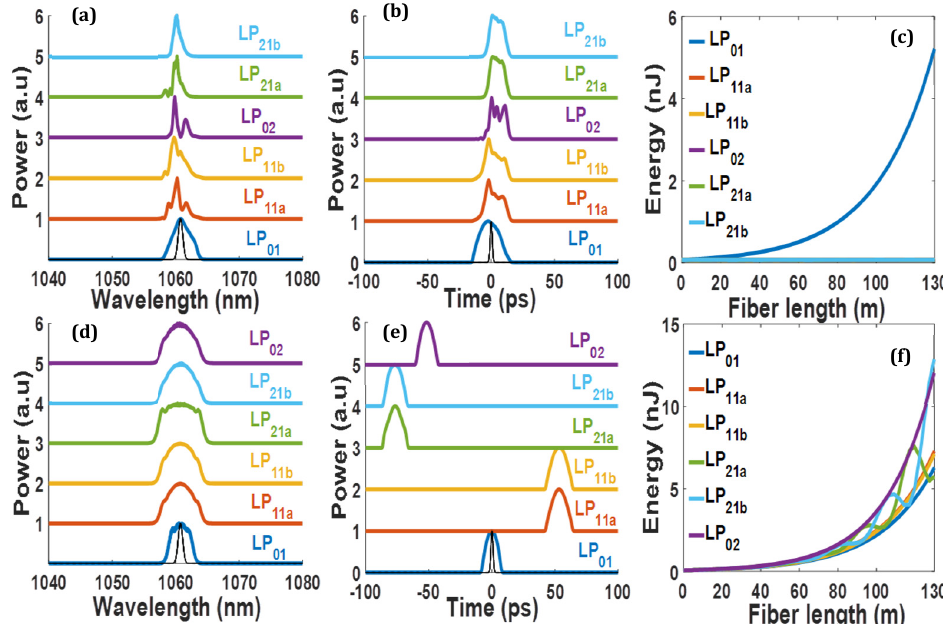
Figure 5. ( a – c ) Spectral, temporal forms and pulse energy evolutions for 130 m of pulse propagation for all the modes in the GRIN-F, and ( d – f ) in the STEP-F, respectively, where the initial energy is equally distributed among all the modes.